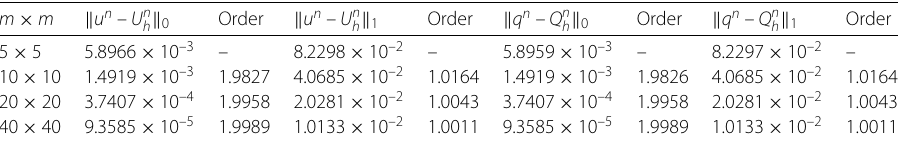
Table 5 Results for (cid:8) u n – U n